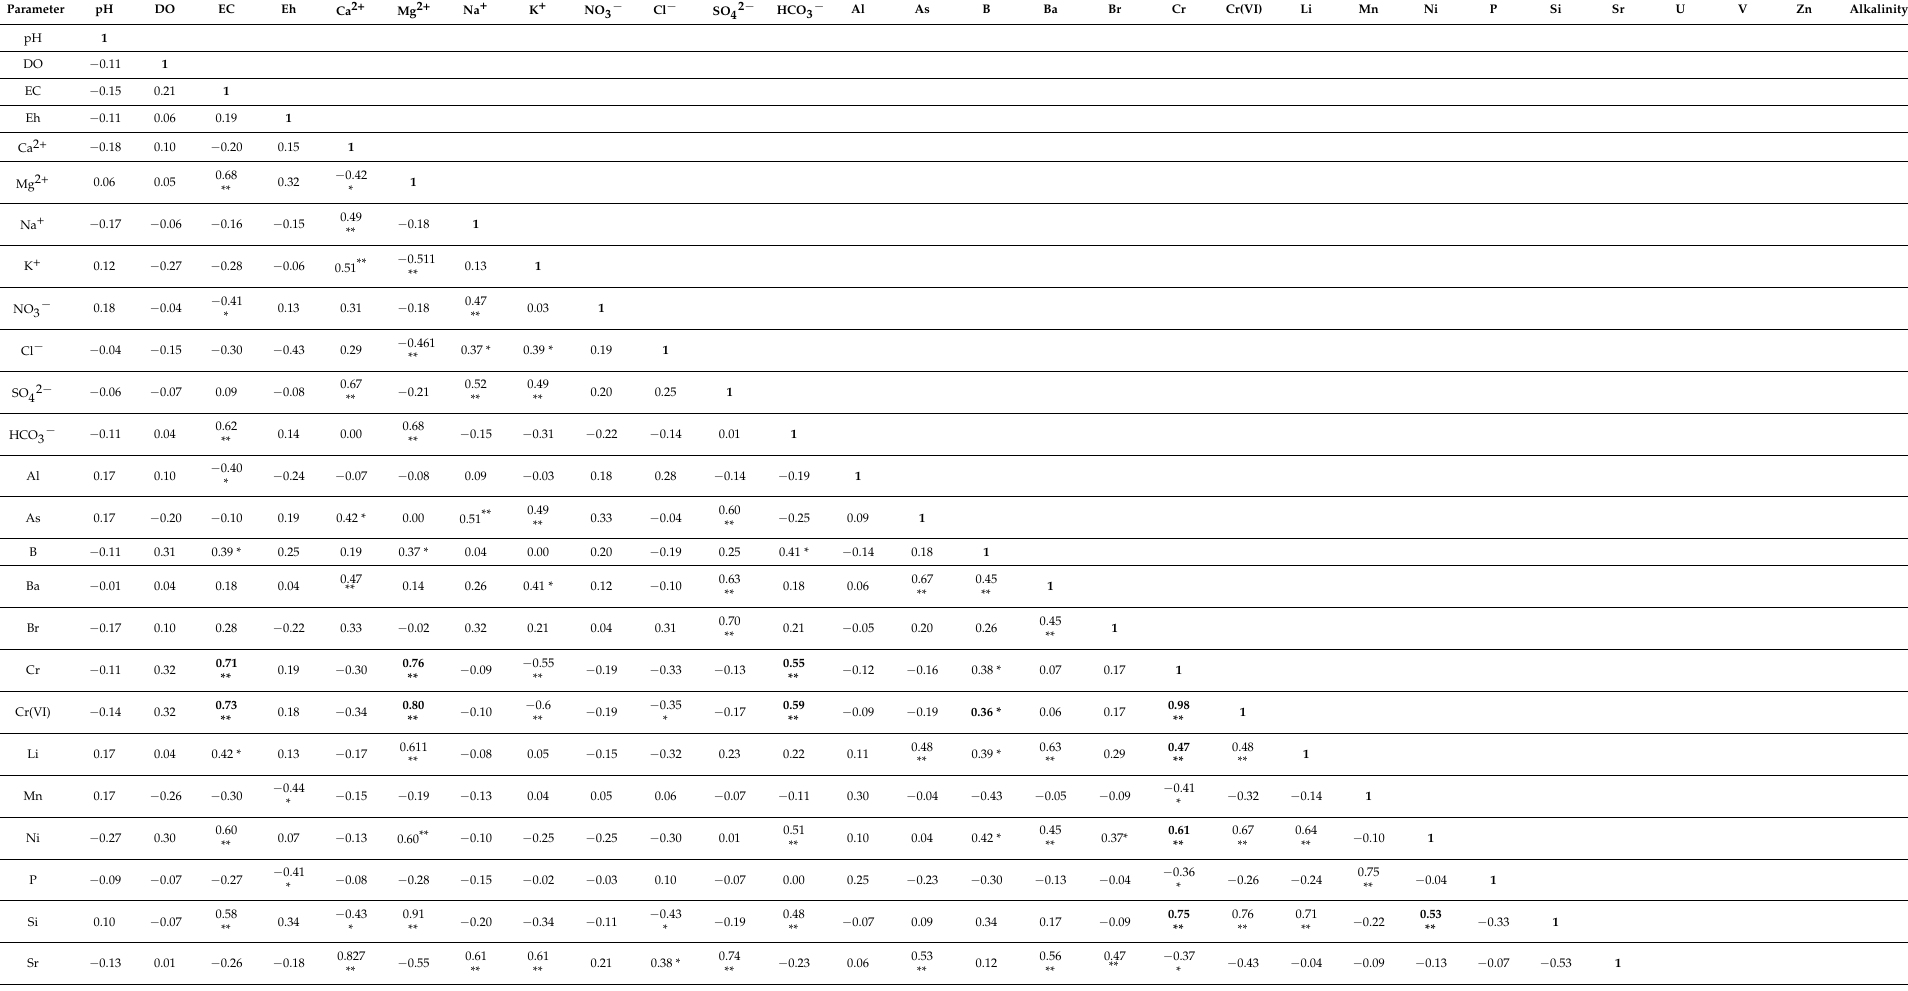
Table 5. Spearman’s rank correlation matrix of selected major and trace elements of the natural springs of western Vermio